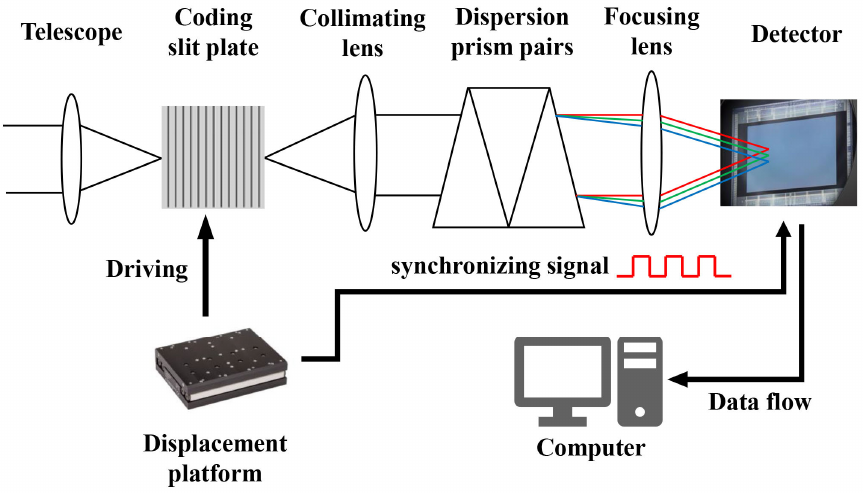
Figure 1. System schematic for the RHVS video acquisition.